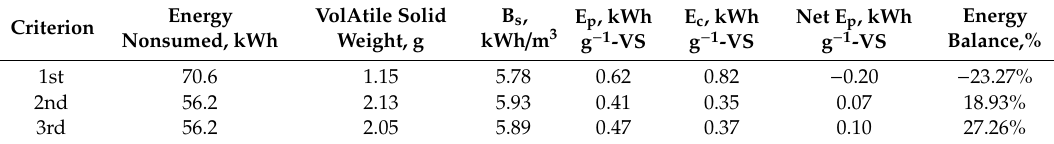
Table 13. Energy evaluation of the optimisation